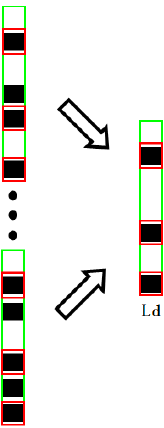
Figure 13. Comparison of the number of character blocks contained in the pieces of area 2. The red boxes mark the character blocks with the same line position in the different pieces.